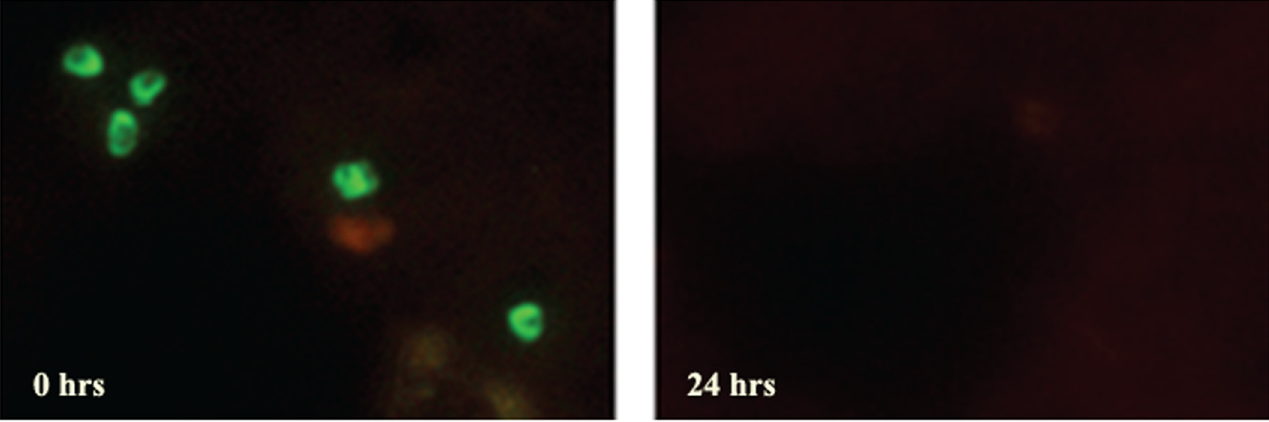
Fig 4. FISH assay only detects live Plasmodium parasites. Blood smears prepared from P . falciparum positive patient before (0 Hrs) and after 24 hours (24Hrs) drug treatment were analyzed by Plasmodium Genus FISH assay. The disappearance of the Plasmodium Genus fluorescence signal at 24 hours suggests that FISH assay only detects live Plasmodium